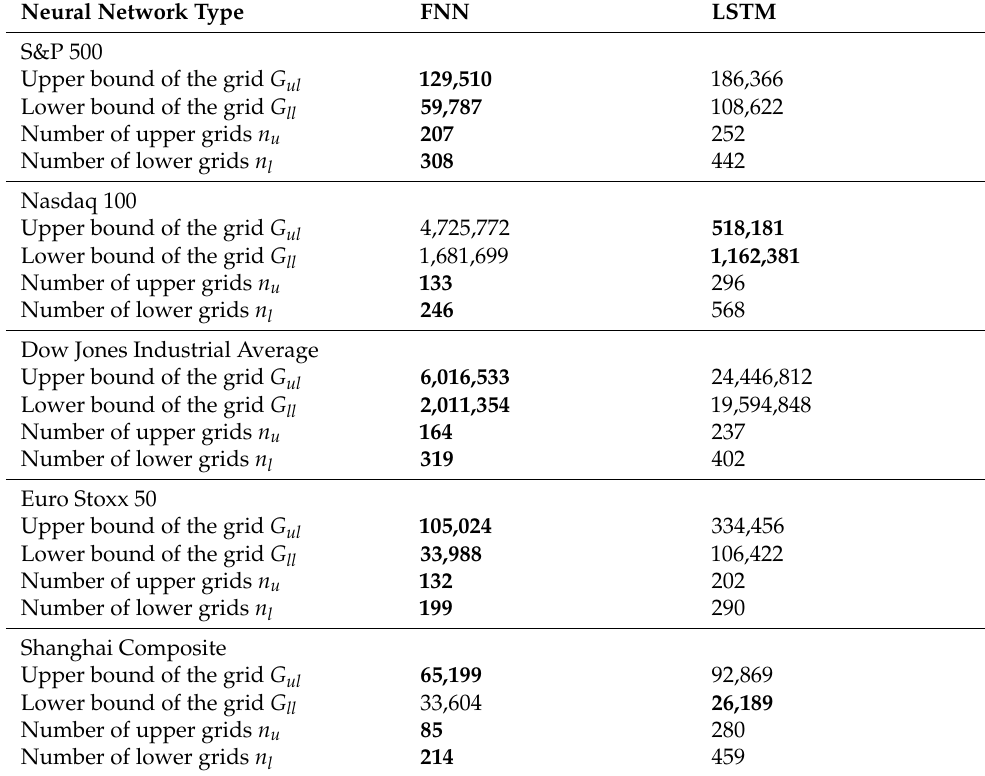
Table 14. Mean square error of values for output layer including upper bound of the grid G ul , lower bound of the grid G ll , number of upper grids n u , and number of lower grids n l comparison between FNN and LSTM